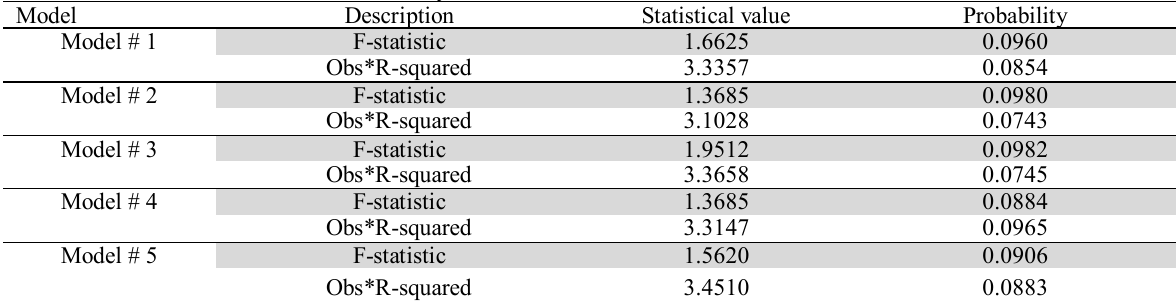
The results of White homoscedasticity test Model